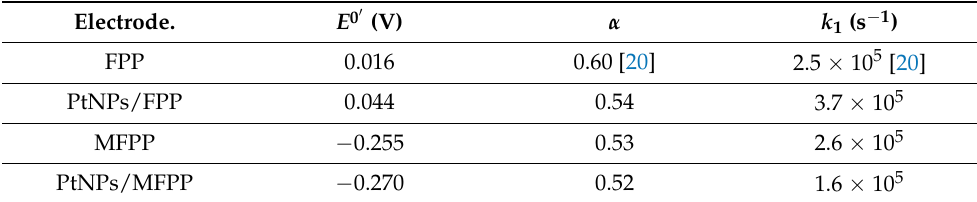
Table 1. Characterization of the electrodeposited redox system at the modified electrodes. Electro- chemical and kinetic parameters.